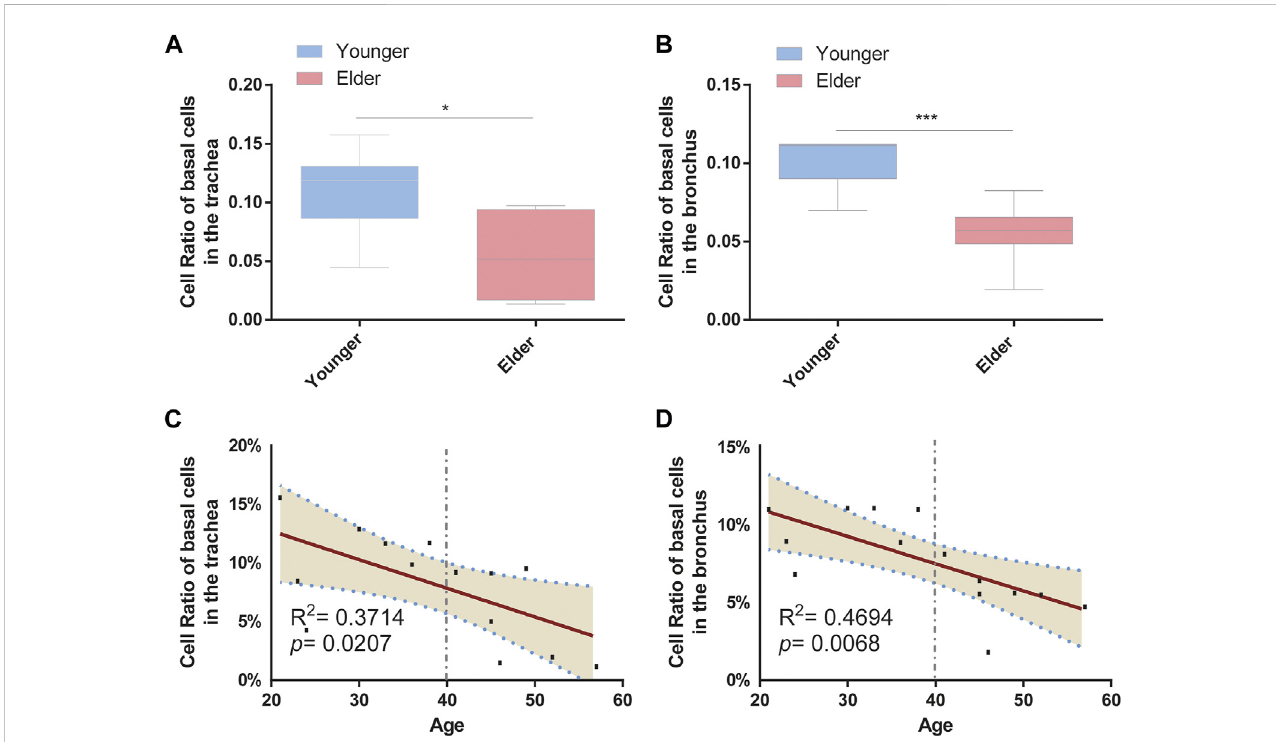
FIGURE 3 Proportion of basal cells decreased with age in the airway. (A) Proportion of basal cells between the younger and elder groups in the trachea. * p < 0.05. (B) Proportion of basal cells between the younger and elder groups in the bronchus. *** p < 0.001. (C) Pearson correlation analysis about the proportion of basal cells and age in the trachea. Pearson R and p are shown. The broken line represents the 95% con fi dence interval (CI). (D) Pearson correlation analysis about the proportion of basal cells and age in the bronchus. Pearson R and p are shown. The broken line represents the 95% con fi dence interval